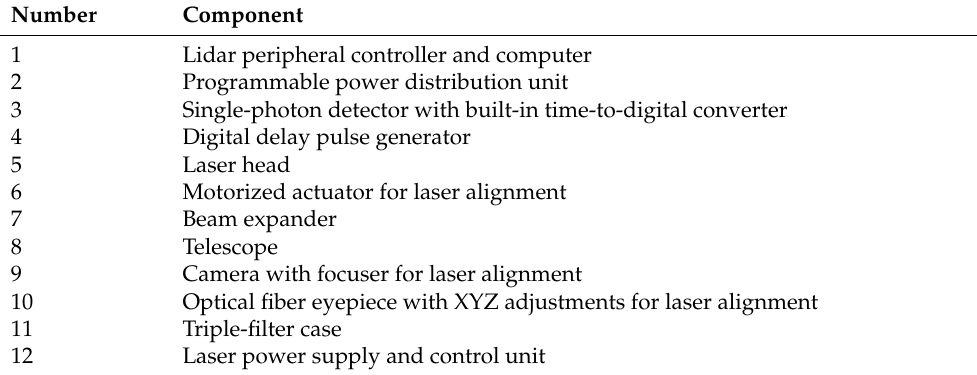
Figure 1. ( a ) Photo of exterior of T2 lidar. ( b ) Photo of interior of T2 lidar. ( c ) Lidar component flow diagram. Numbered components are detailed in Table 1. Table 1. List of T2 lidar